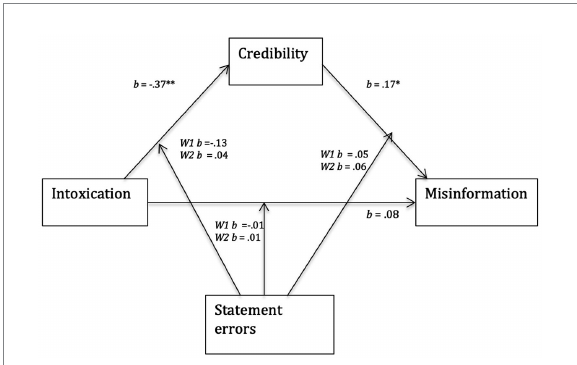
FIGURE 1 Moderated mediation model examining the mediating effect of perceived credibility on the relationship between witness intoxication and the tendency to report misinformation. Additionally, whether this mediating effect is moderated by the number of statement errors, at low vs. no (W1) and high (W2) levels. * Denotes significance at p = 0.01, ** denotes significance at p = 0.001.